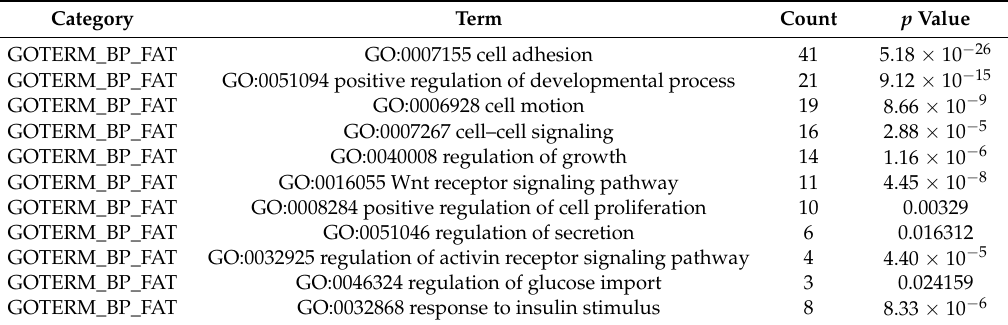
Table 1. Gene ontology (GO) terms segregation of 196 predicted target genes of upregulated microRNAs. GO term category, GO ID and specification, number of genes (count), and p -value of each specific GO term is